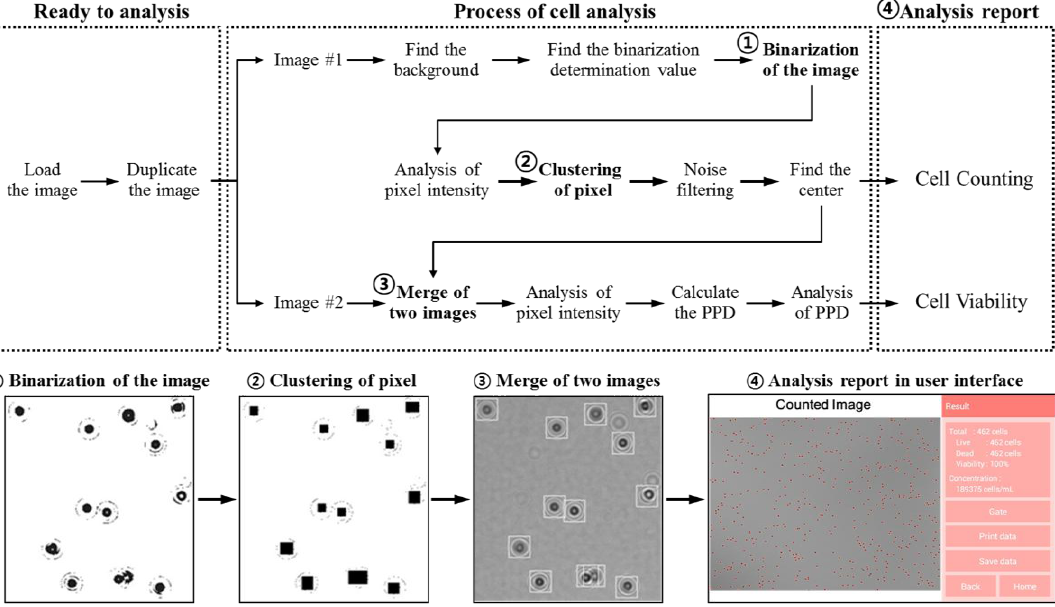
Figure 2. Concise workflow of the algorithm for the processing of the lens-free shadow image. The algorithm consists of binarized image, clustering, counting and viability analysis. Bottom pictures show how the original image is transformed at critical steps.